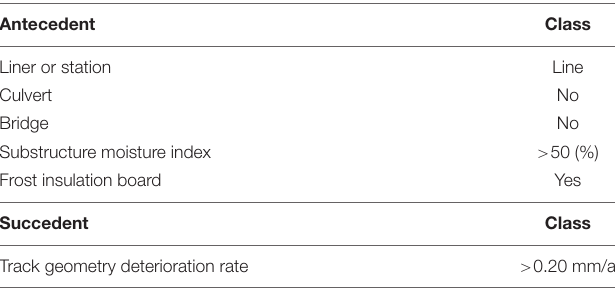
TABLE 5 | Attributes for analytical question 1